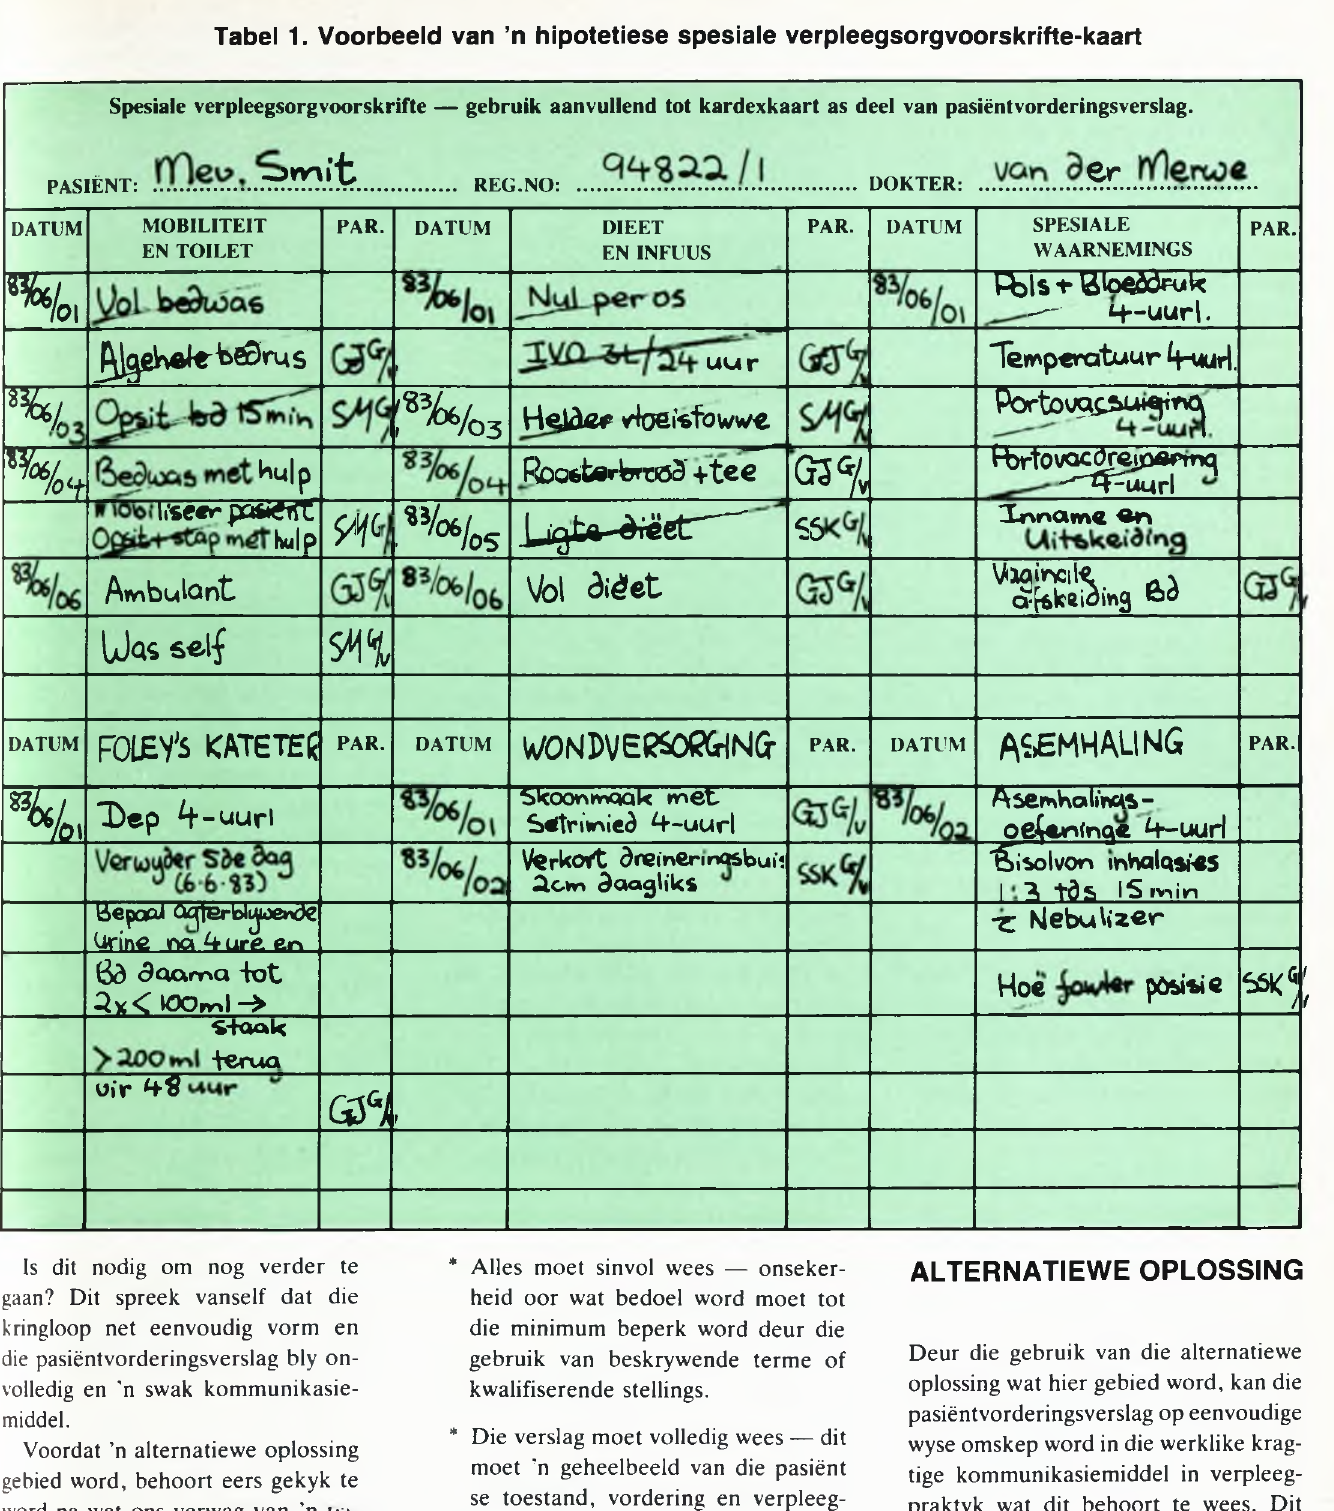
Tabel 1. Voorbeeld van ’n hipotetiese spesiale verpleegsorgvoorskrifte-kaart Spesiale verpleegsorgvoorskrifte — gebruik aanvullend tot kardexkaart as deel van